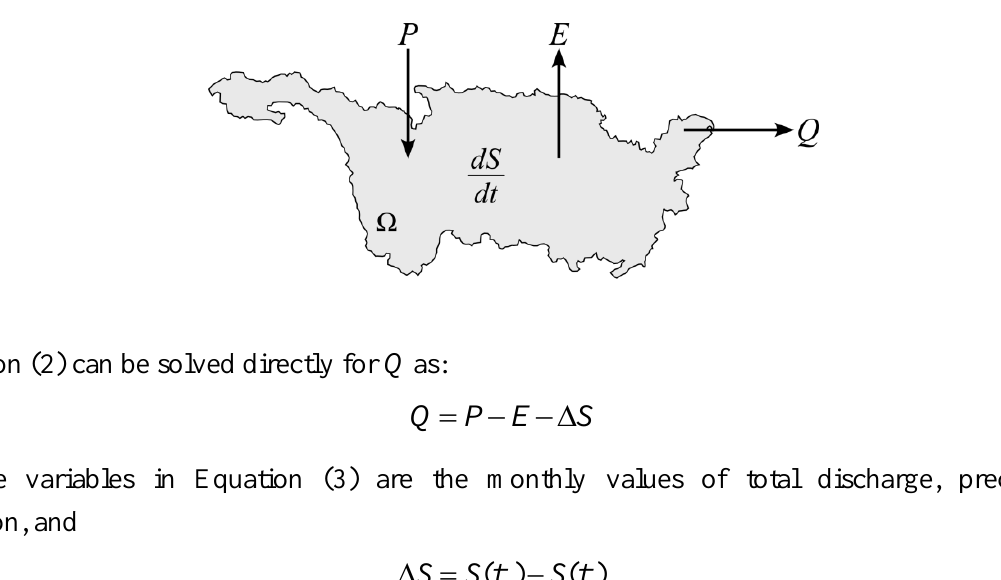
Figure 3. A simplified scheme for the relation of quantities in the land water